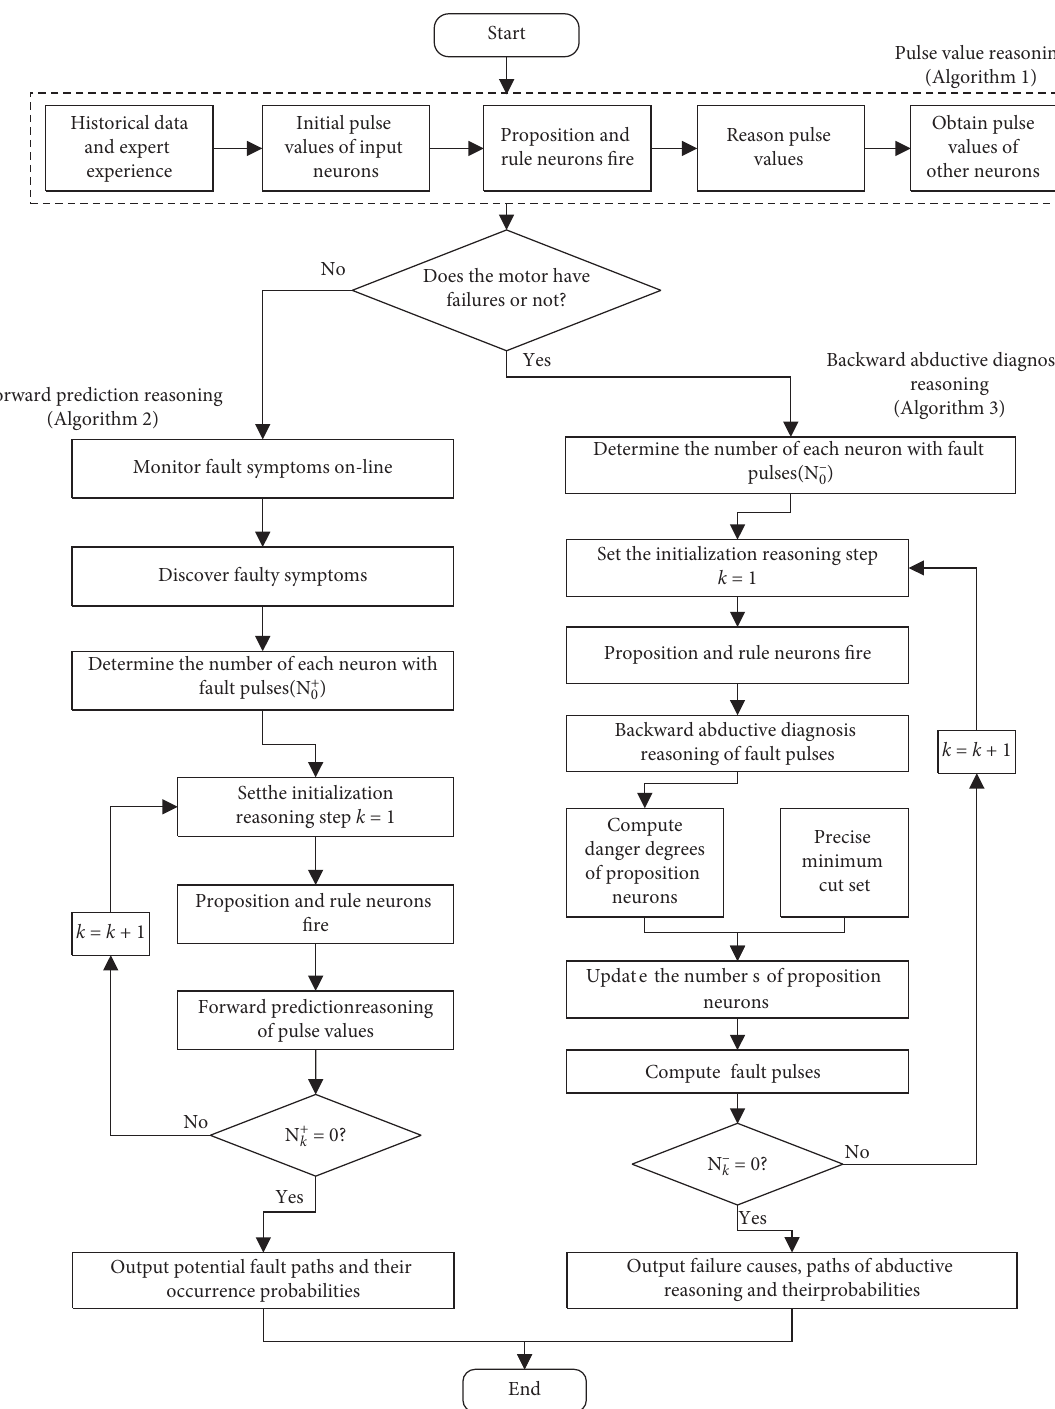
Figure 4: Fault reasoning flow chart based on